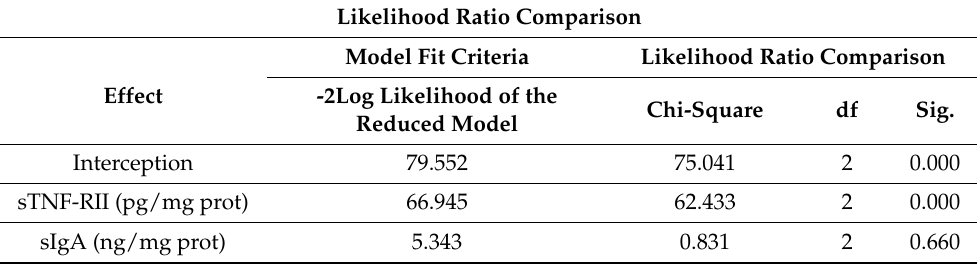
Table 4. Parameters for adjusting the multivariate logistic model between the PAINAD scale (three categories) and sTNF-RII and sIgA.